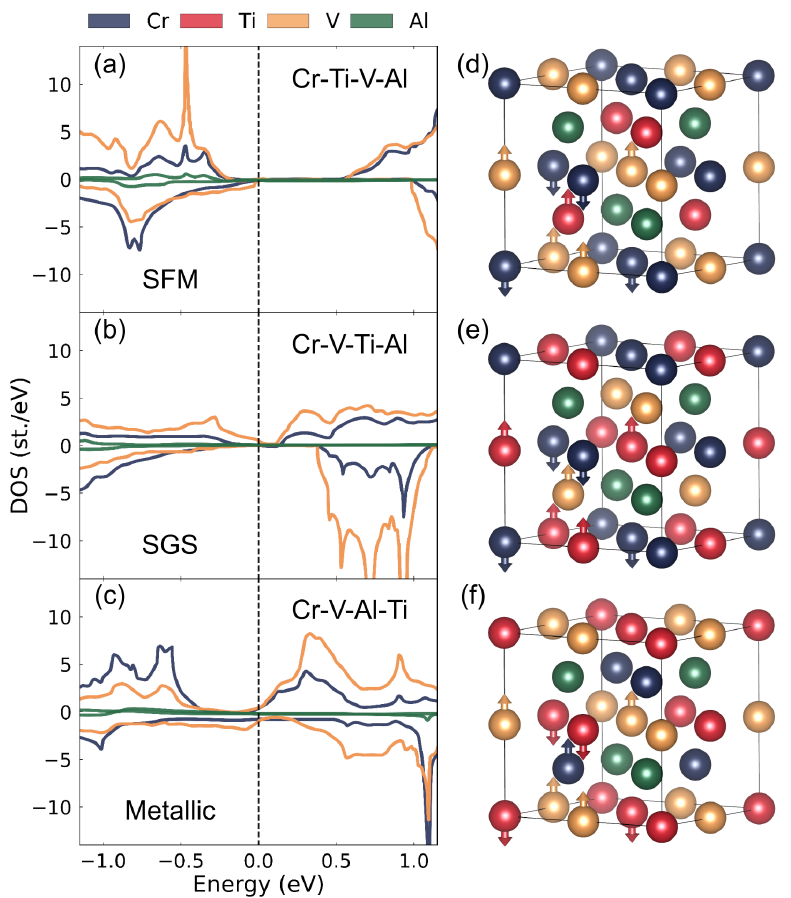
Figure 21. ( a – c ) The element-resolved DOSs and ( d – f ) crystal structures for various arrangements of Cr, V, Ti, and Al with a schematic representation of the AFM order